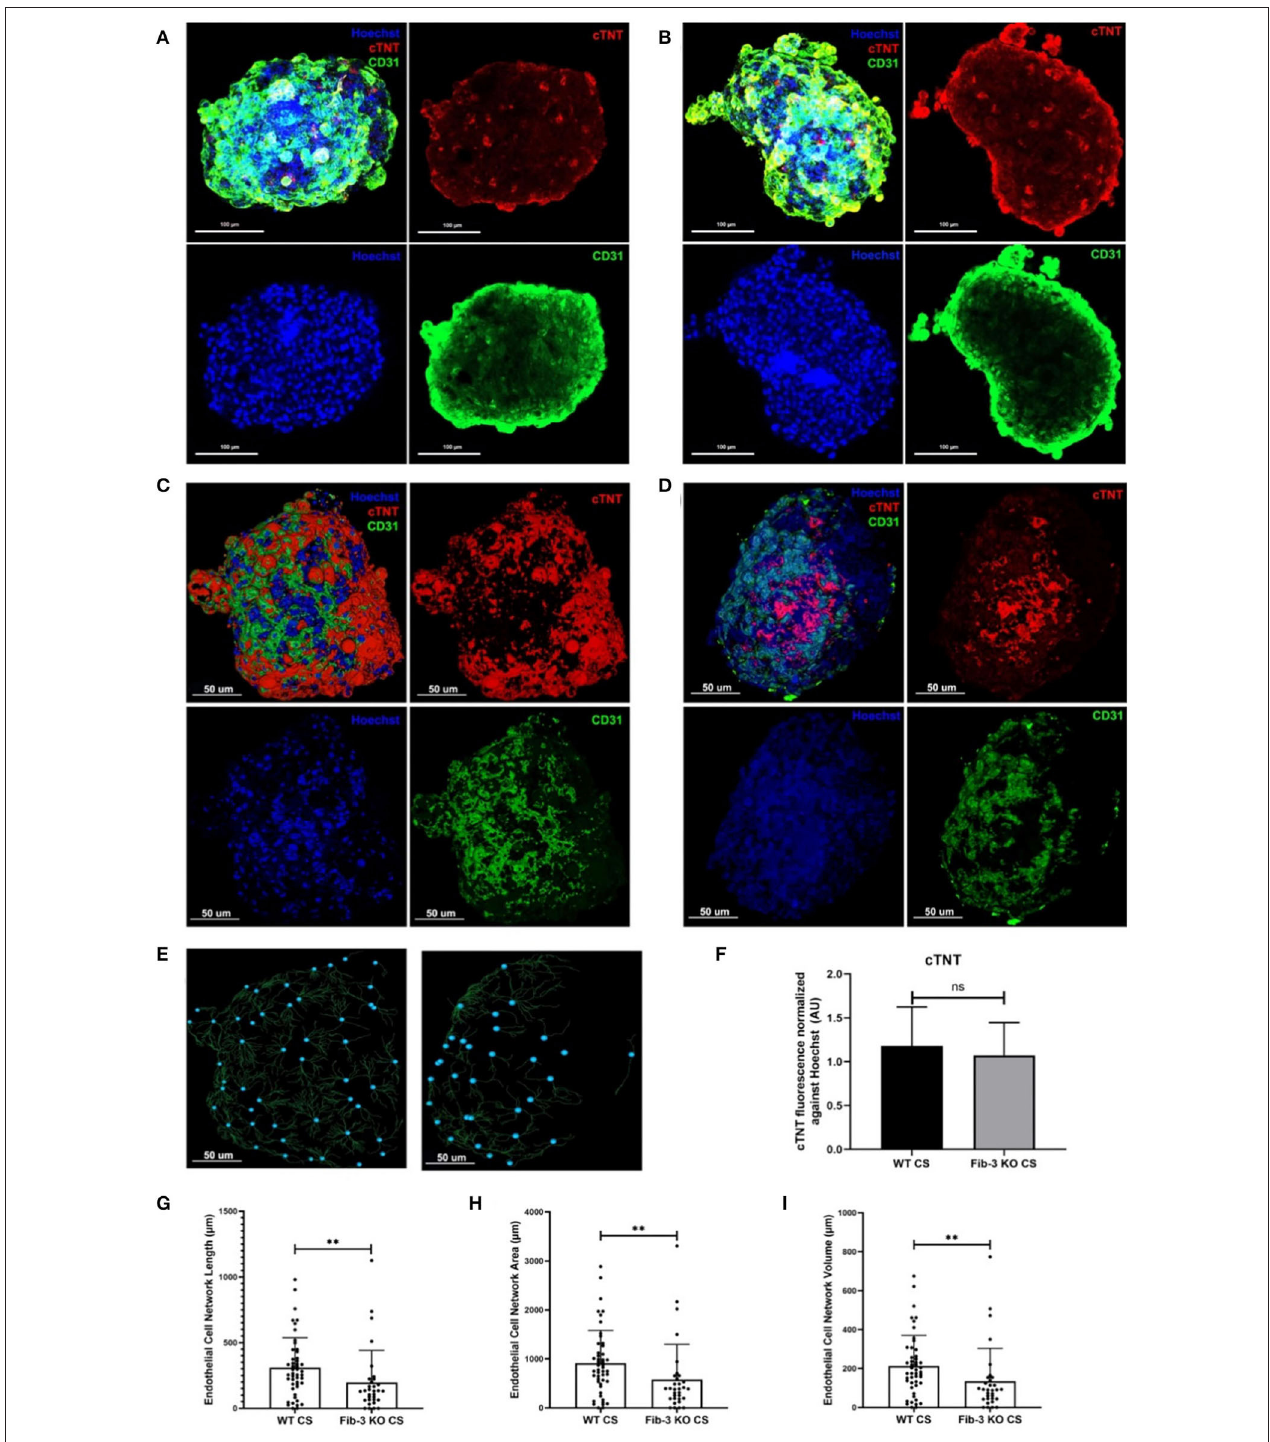
FIGURE 2 | Fib-3 KO CS demonstrate reduced CD31-positive endothelial cells compared to WT CSs. (A, B) Collapsed Z-stacks of confocal images of WT and Fib-3 KO CS stained with antibodies against CD31 for endothelial cells (green), cTNT for cardiomyocytes (red) and Hoechst for nuclei (blue). (C, D) 3D rendering analyses of confocal images of WT (A) and Fib-3 KO CS (B) , respectively. (E) 3D representation of endothelial cell network formation in WT and Fib-3 KO CS (blue dots represent foci of the endothelial cell network formed within each CS). (F) Statistical analyses of expression of cTNT normalized against Hoechst stain in WT and Fib-3 KO CSs, ( n = 5). (G–I) Statistical analyses of endothelial cell network length, area and volume in WT and Fib-3 KO CSs. Unpaired t -test, p > 0.05 = ns, p < 0.01 = **. Error bars represent the mean ± SD ( n > 32).